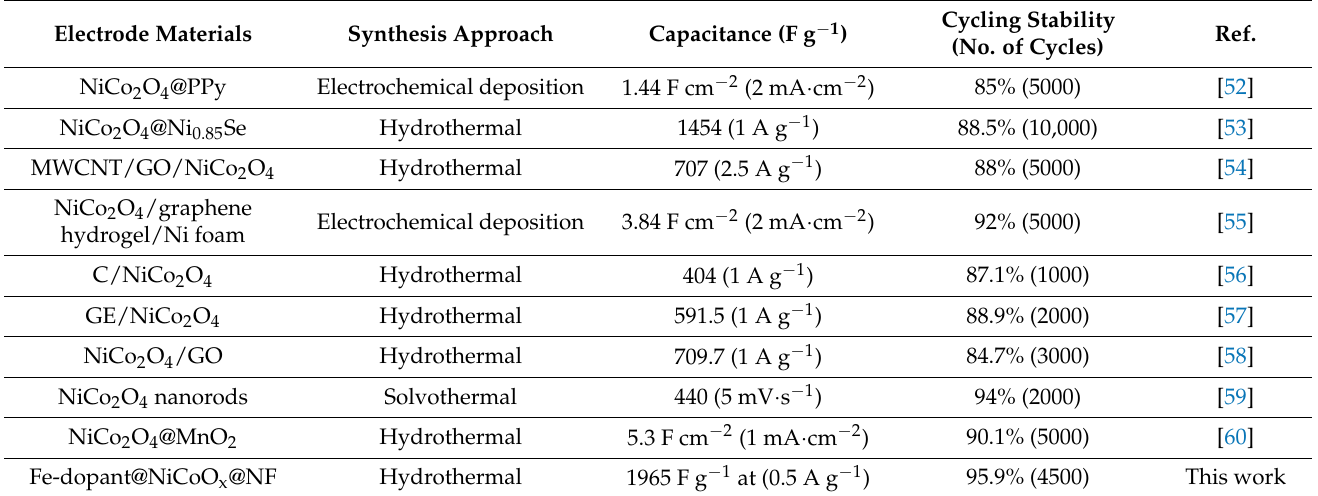
Table 1. Specific capacitance comparisons between recent reports of transition metals and our